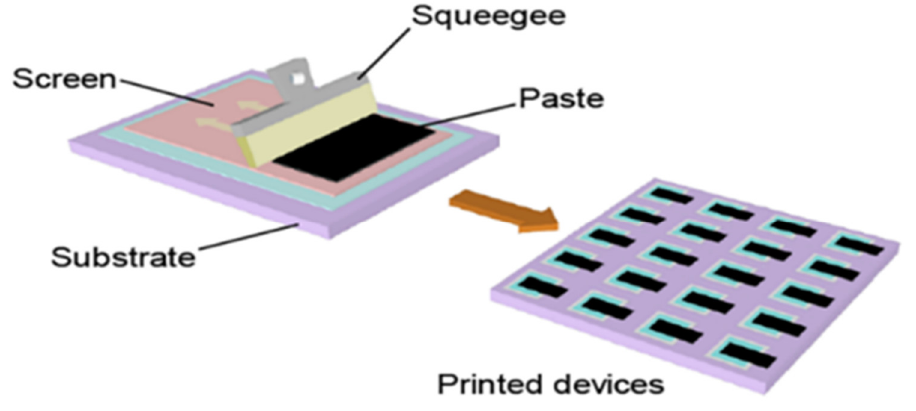
Figure 8. Schematic representation of screen-printing [86].